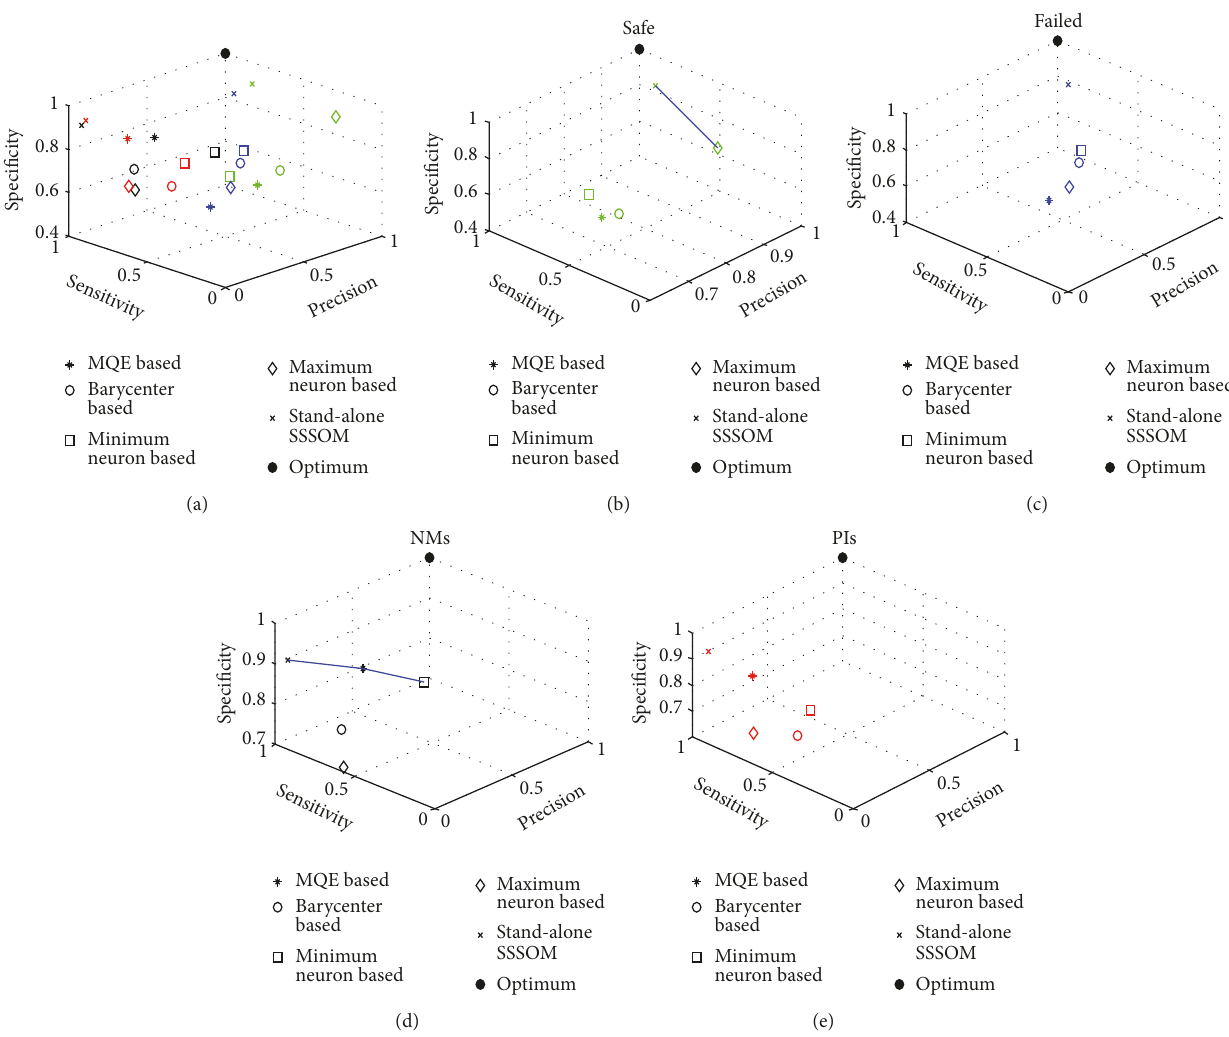
Figure 3: 3D representation of the performance parameters. Red refers to PIs, black to NMs, blue to failed, and green to safe